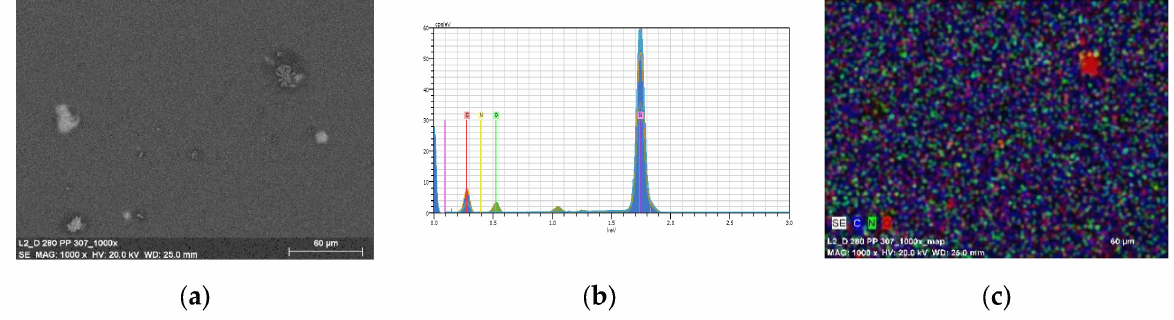
Figure 16. ( a ) SEM of L2/ Si from thermal vapor deposition; ( b ) EDS and ( c )